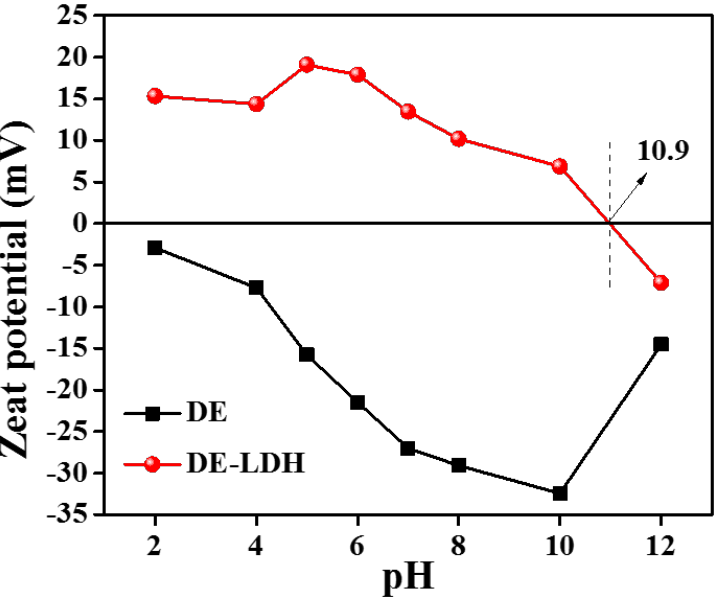
Figure 4. The zeta potential measurement of DE and DE-LDH.